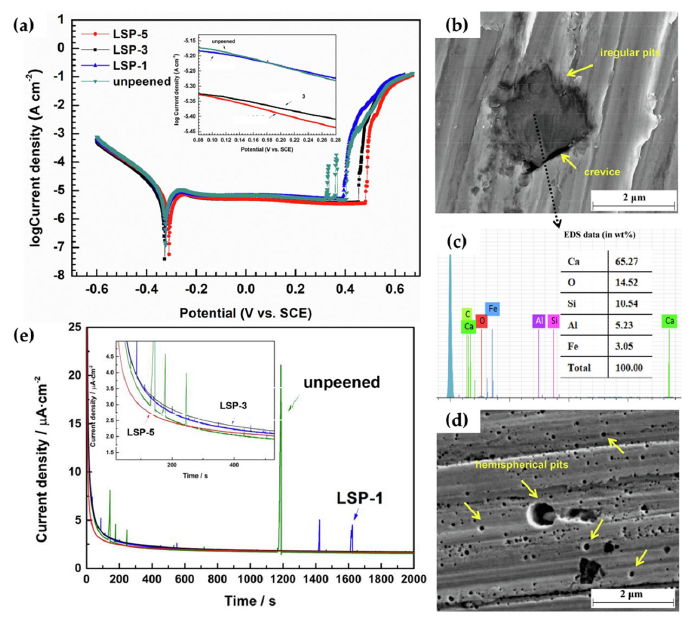
Figure 11. The ( a ) potentiodynamic polarization curves and pitting morphologies of ( b ) bare ‐ 304 L steel substrate (with its EDS analysis within the pit ( c )) and ( d ) its LSP counterpart at a repeated impact rate of five. Additionally, the ( e ) potentiostatic polarization curves illustrate their pitting frequencies [111].